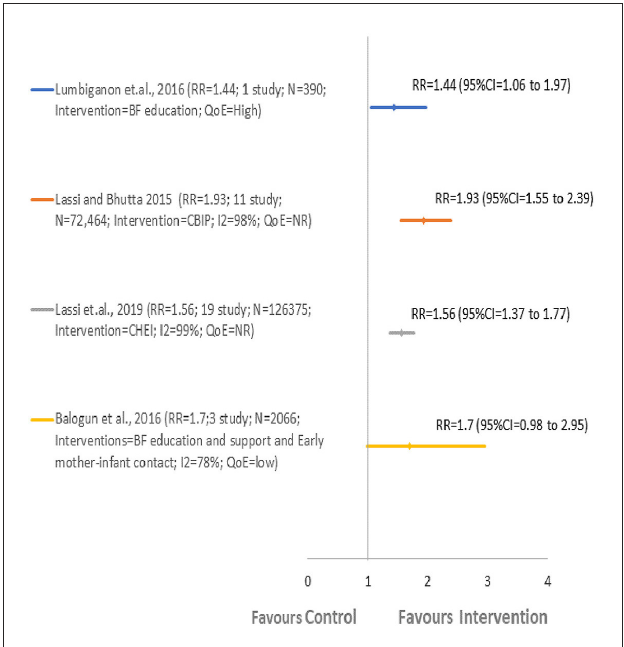
FIGURE2 Comparison 1: BF intervention vs. routine care. EIBF, early initiation of breastfeeding.